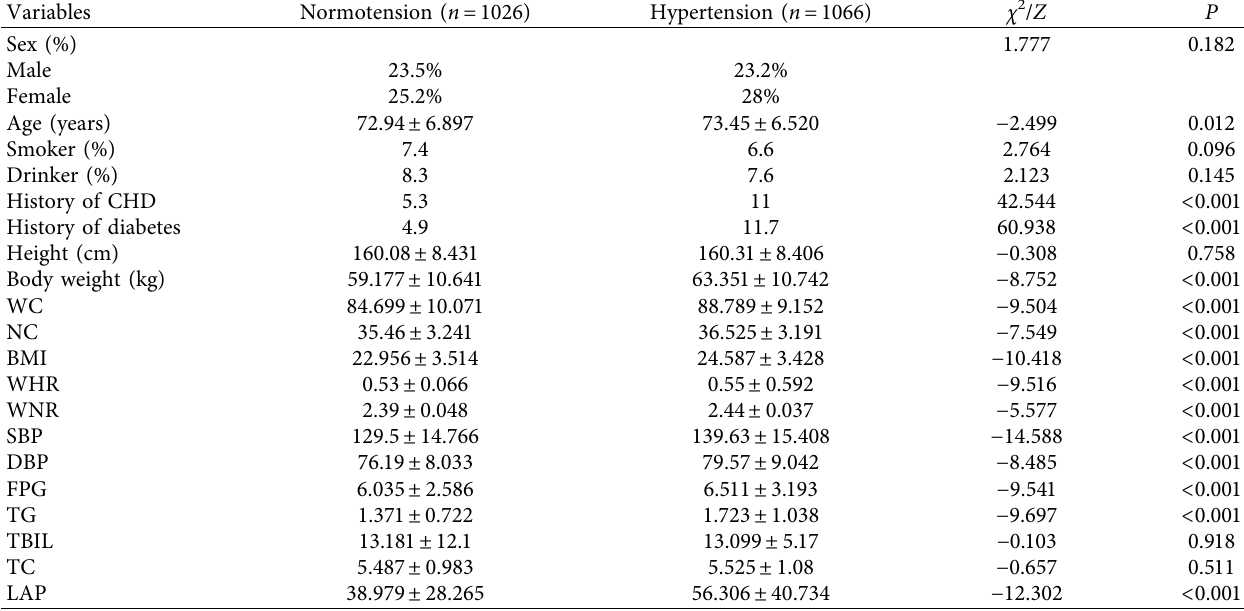
Table 1: Baseline characteristics of subjects.